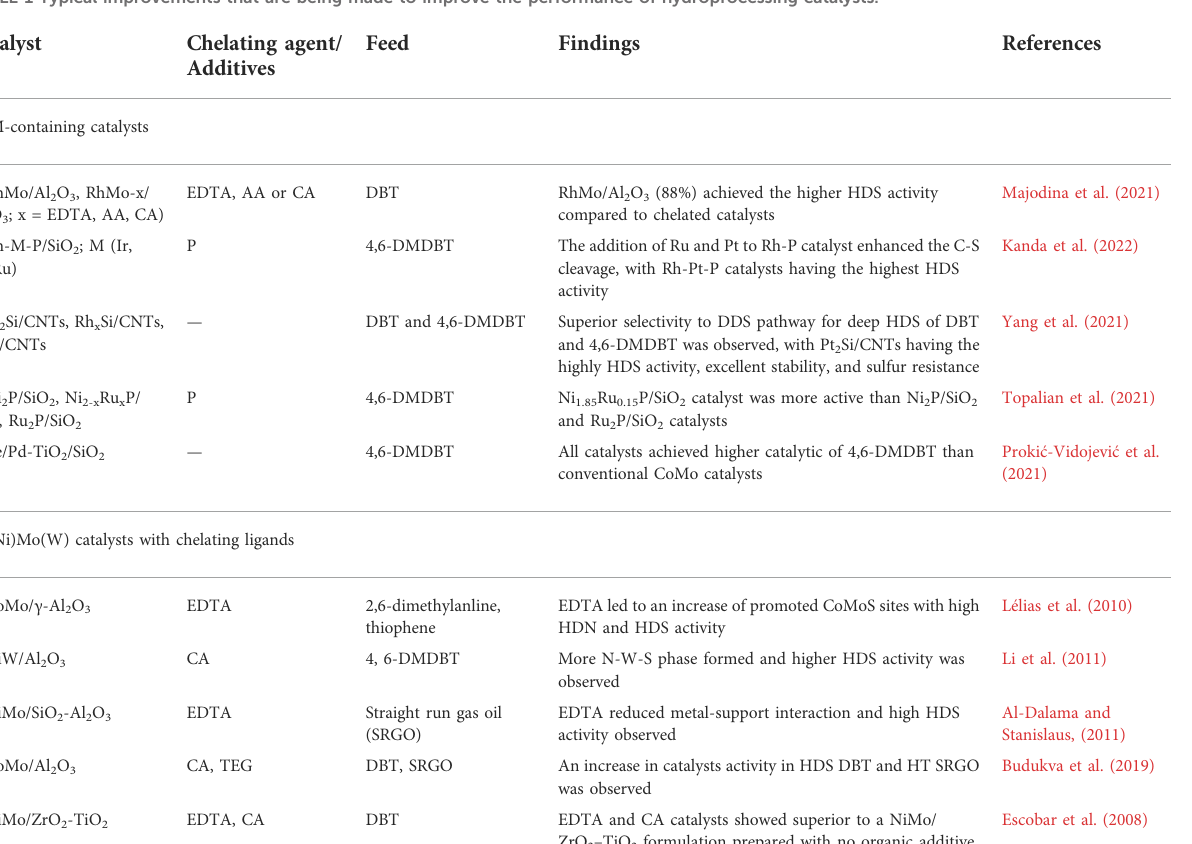
TABLE 1 Typical improvements that are being made to improve the performance of hydroprocessing